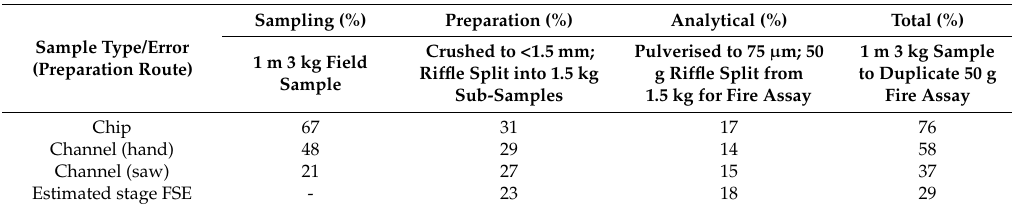
Table 23. Example from a North American mine of RSV values for duplicates taken across each mine face [42]. See also Table 24, Mine B example.